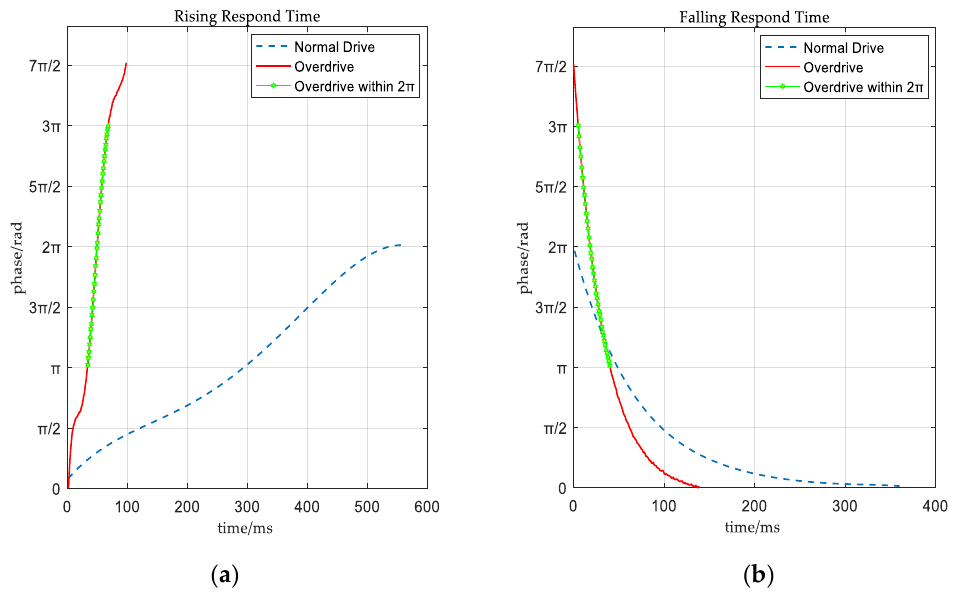
Figure 7. Response time of ( a ) the rising process and ( b ) the falling process with different driving voltage.